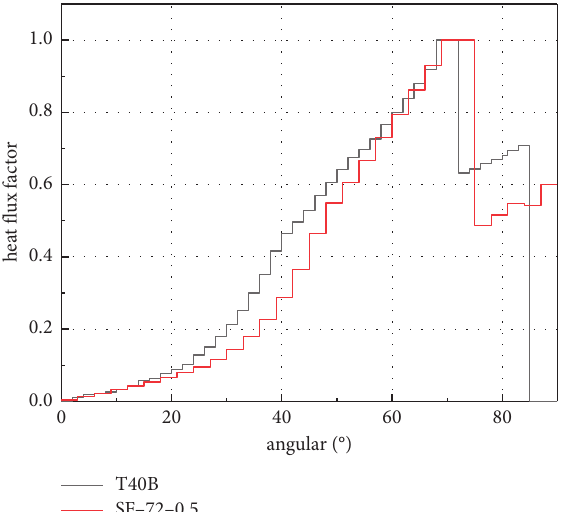
Figure 16: Power shape of T40B and